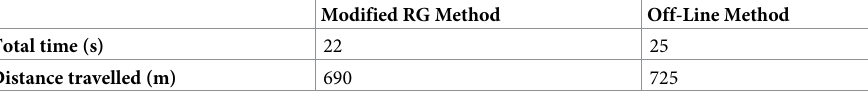
Table 10. Basic overtaking parameters for scenario 4 –a comparison.